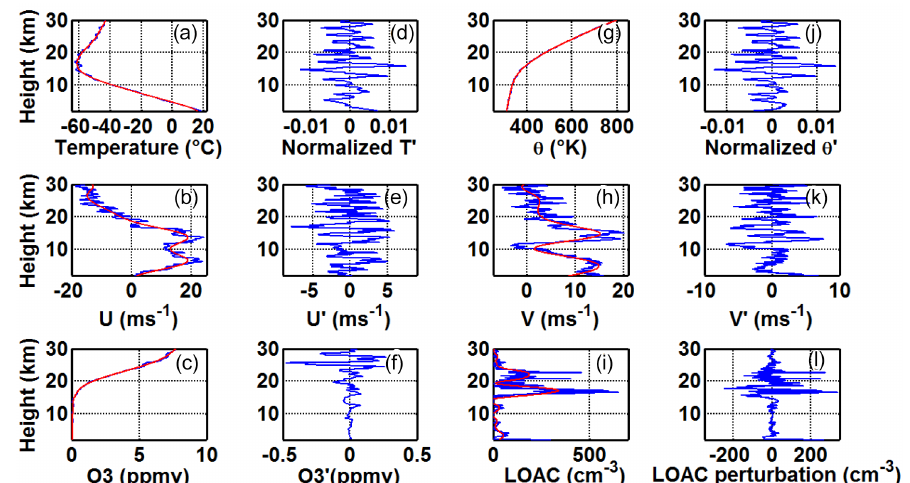
Figure 3. Filtered vertical profiles of temperature ( ◦ C), potential temperature ( ◦ K), zonal and meridional winds (ms − 1 ) , ozone, LOAC aerosol concentration (cm − 3 ) of 0.2–0.7µm size classes (a, b, c, g, h, i) and perturbations (d, e, f, j, k, l) on 27 July at 23:03UTC above Ile du Levant (43.02 ◦ N, 6.46 ◦ E). Solid blue (red) line visualises filtered (background) profile. The prime symbol ( (cid:48) ) means